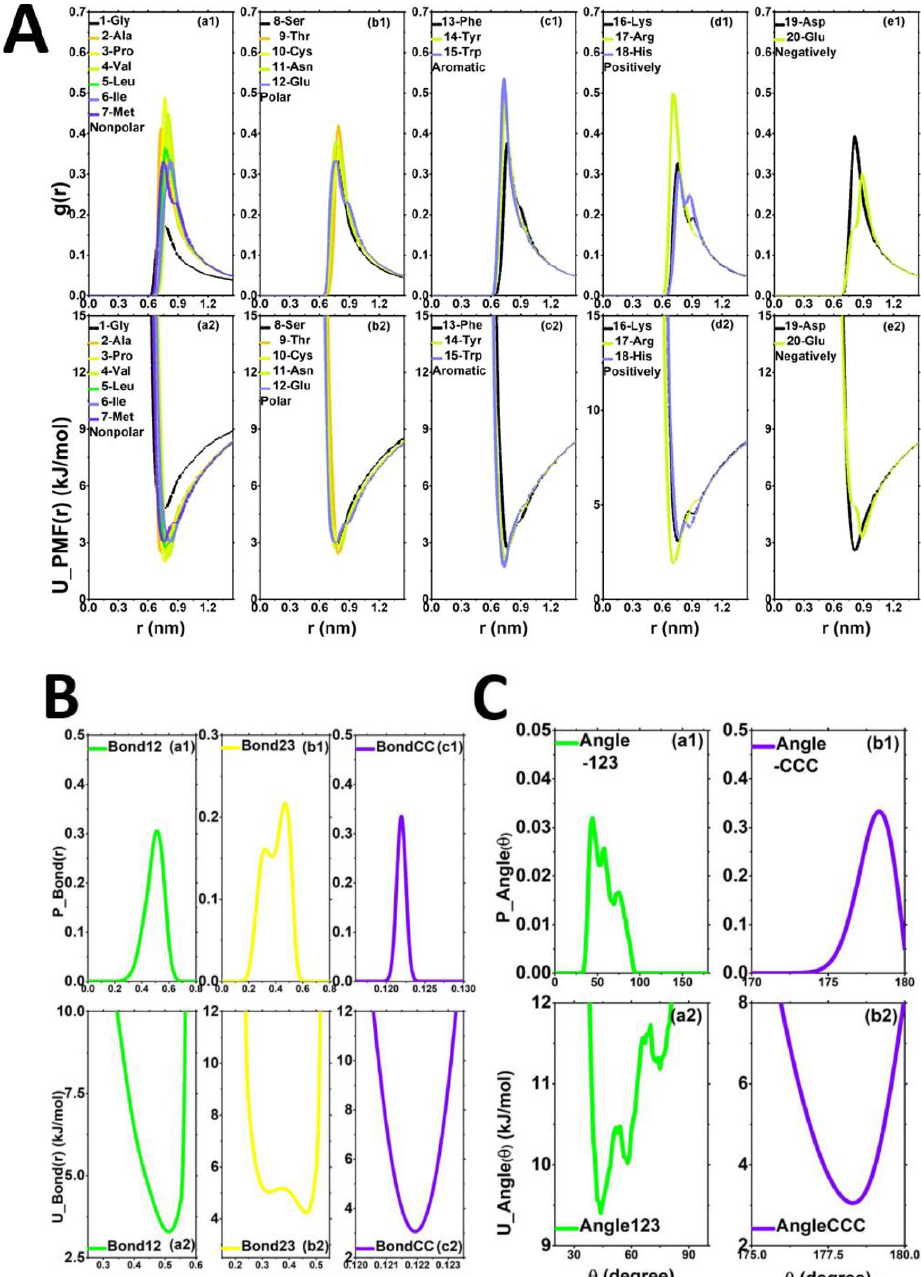
Figure 3. ( A ) The radial distribution functions between different types of amino acids and carbon nanotubes and their potential energy functions extracted by full-atom simulation: non-polar amino acid group RDF ( a1 ) and its U_PMF(r) ( a2 ); the RDF ( b1 ) of the polar uncharged amino acid group and its U_PMF(r) ( b2 ); aromatic amino acid group RDF ( c1 ) and its U_PMF(r) ( c2 ); the positively charged amino acid group RDF ( d1 ) and its U_PMF(r) ( d2 ); the negatively charged amino acid group RDF ( e1 ) and its U_PMF(r) ( e2 ). ( B ) The bond distribution functions extracted by the all-atom simulation and its potential energy function (take CNT55L3-15-Trp as an example): NH2- amino acids, ( a1 ) P_Bond(r), ( a2 ) U_Bond(r); amino acids-ACE, ( b1 ) P_Bond(r), ( b2 ) U_Bond(r); CNT-CNT, ( c1 ) P_Bond(r), ( c2 ) U_Bond(r). ( C ) The distribution of the angle distribution function extracted by the all-atom simulation and its potential energy function (take CNT55L3-15-Trp as an example): NH2-amino acids-ACE, ( a1 ) P_Angle( θ ), ( a2 ) U_Angle( θ ); CNT-CNT-CNT, ( b1 ) P_Angle( θ ), ( b2 ) U_Angle( θ